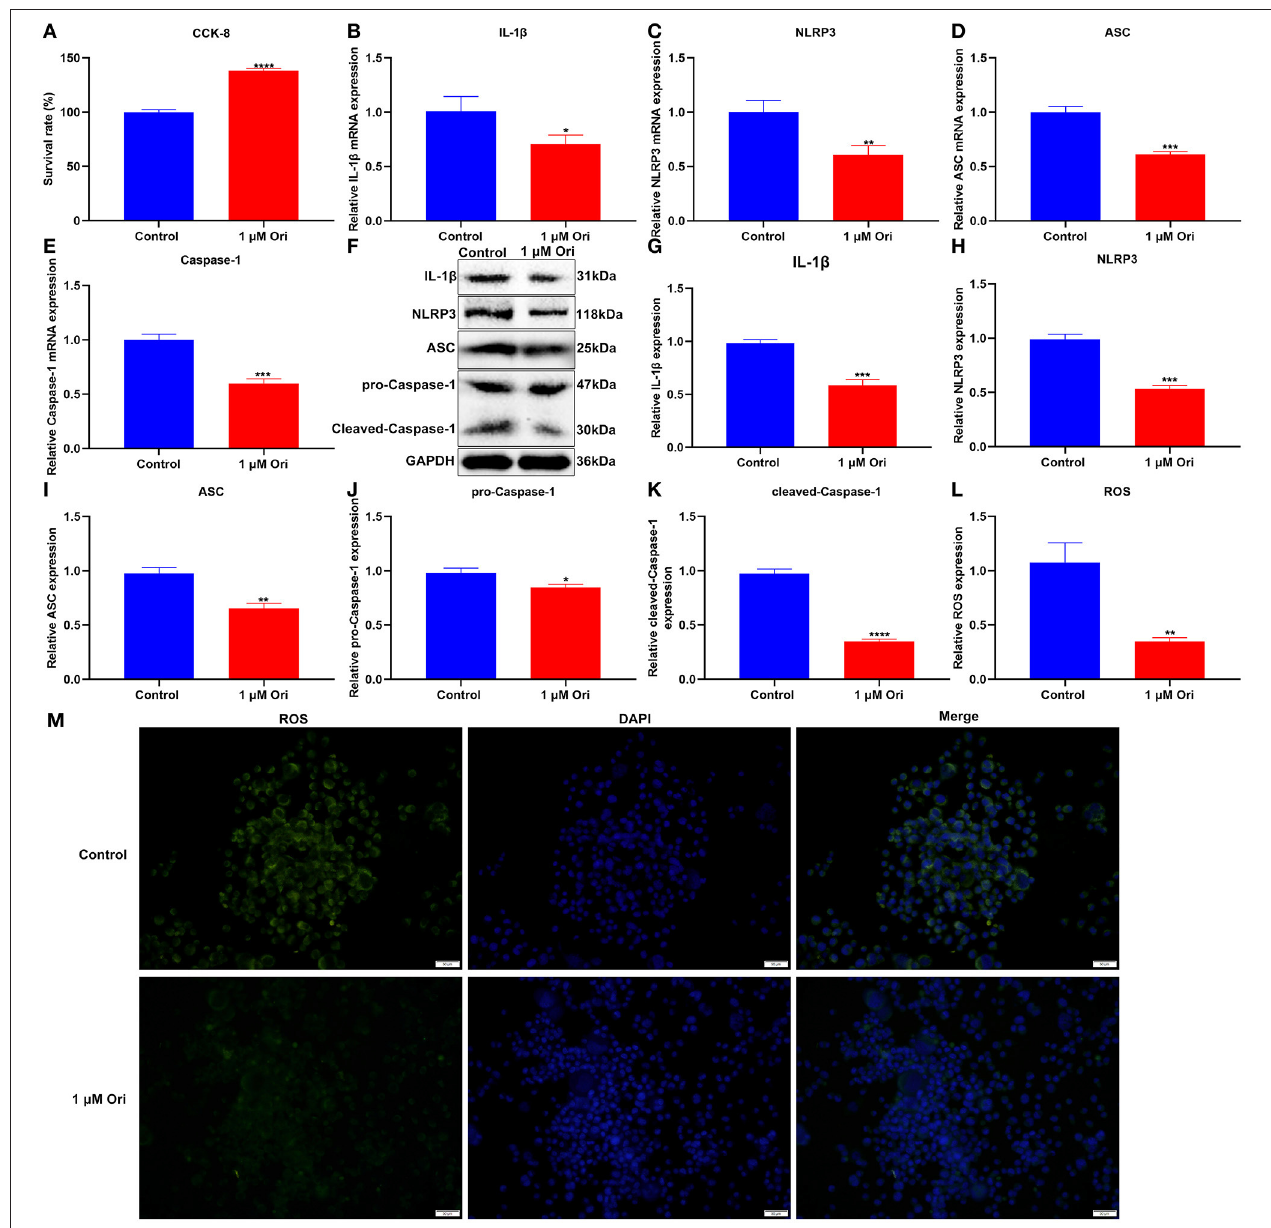
FIGURE 5 | Effect of 1 µ M Ori on NLRP3 inflammasome activation and ROS accumulation in astrocytes. (A) The cell viability of astrocytes treated with 1 µ M Ori according to CCK-8 assay. (B–E) RT-qPCR of the relative mRNA expression of IL-1 β , NLRP3, ASC and Caspase-1 in astrocytes treated with 1 µ M Ori. (F) Representative blots showing IL-1 β , NLRP3, ASC, pro-Caspase-1, and cleaved-Caspase-1 in astrocytes treated with 1 µ M Ori. (G–K) Quantitative analysis of the expression of IL-1 β , NLRP3, ASC, pro-Caspase-1, and cleaved-Caspase-1 according to the western blotting results. (L) Representative H2DCF-DA fluorescence staining of ROS in astrocytes treated with 1 µ M Ori. (M) Quantitative analysis of the expression of ROS based on the H2DCF-DA fluorescence staining results. Magnification, 200 × (50 µ m). N = 3 each group. P values were calculated with student’s t test. * p < 0.05; ** p < 0.01; *** p < 0.001; **** p <